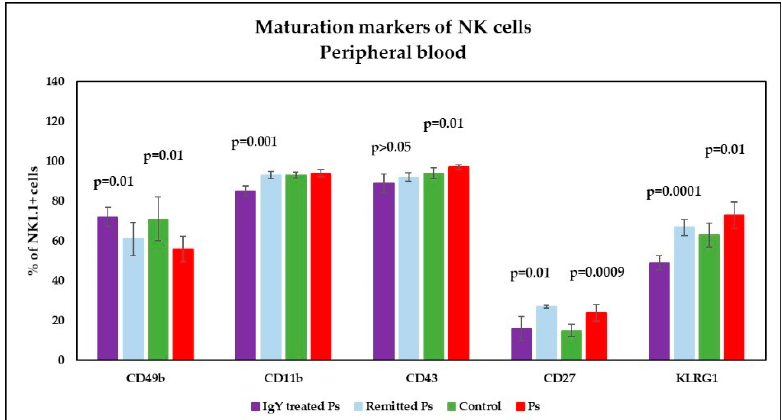
Figure 7. Expression of maturation markers on NK cells in peripheral blood. Expression of CD49b, CD11b, CD43, CD27 and KLRG1 levels on NK1.1 + cells for IgY-treated Ps group (n = 12) (72 ± 4.7; 85 ± 2.7; 89 ± 4.6; 16 ± 6.1; 49 ± 3.7) as compared to naturally remitted Ps group (n = 8) (61 ± 8.3; 93 ± 1.8; 92 ± 2.1; 27 ± 0.8; 67 ± 4.1), control group (n = 8) (71 ± 11; 93 ± 1.5; 94 ± 2.7; 15 ± 3; 63 ± 6) and Ps group (n = 8) (56 ± 6.5; 94 ± 1.8; 97 ± 1.3; 24 ± 4.1; 73 ± 6.6). The results (% of NK1.1 + cells) are presented as mean ± SD; n = number of mice).